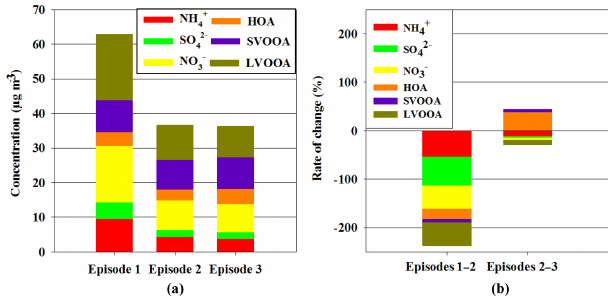
Figure 1. Non-refractory PM 1 chemical components at the Li- ulihe site during the three episodes. (a) Average non-refractory PM 1 chemical components, (b) differences of chemical components among episodes.